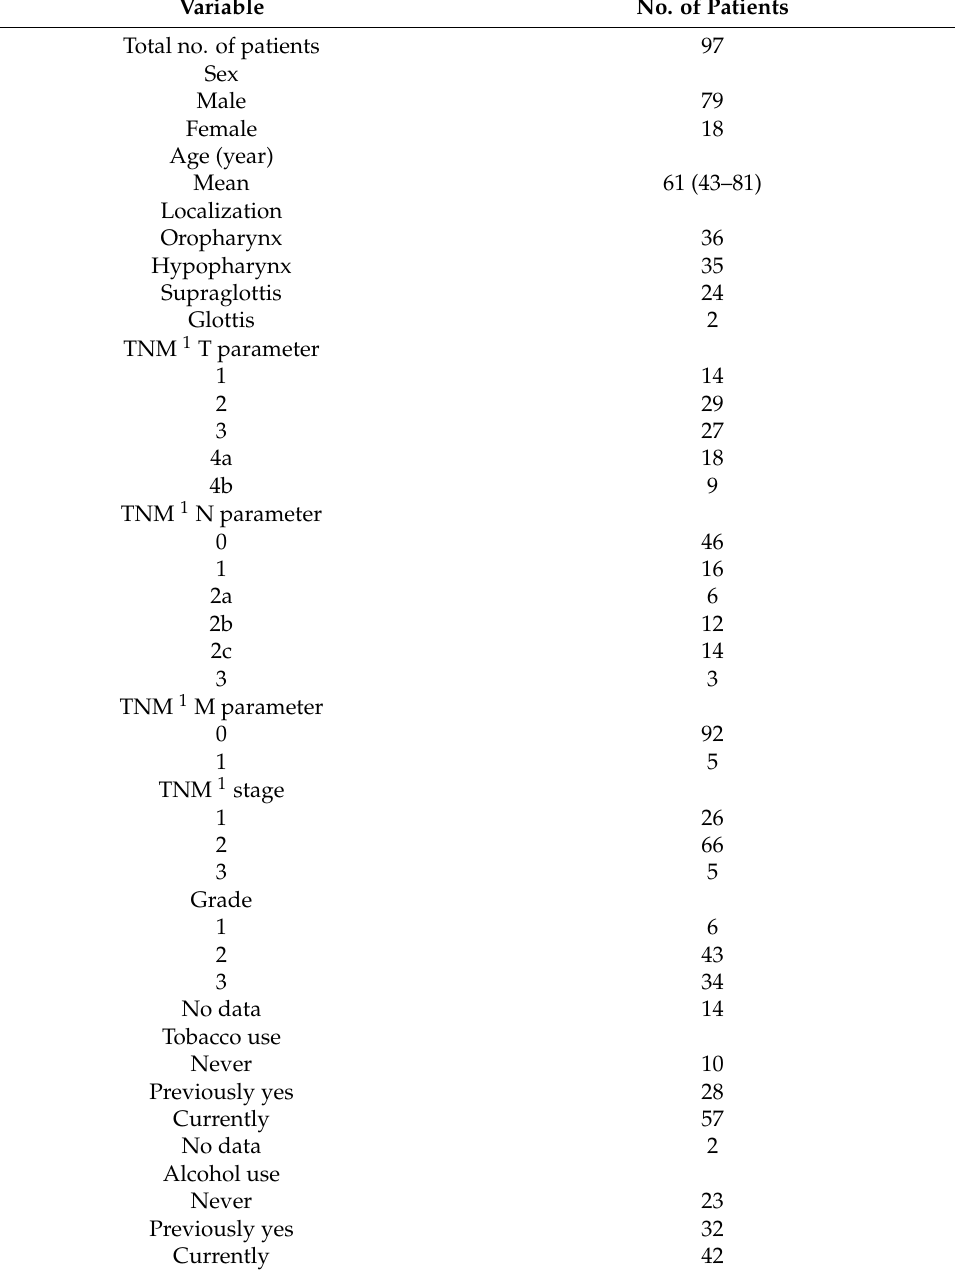
Table 1. Patient characteristics at time of